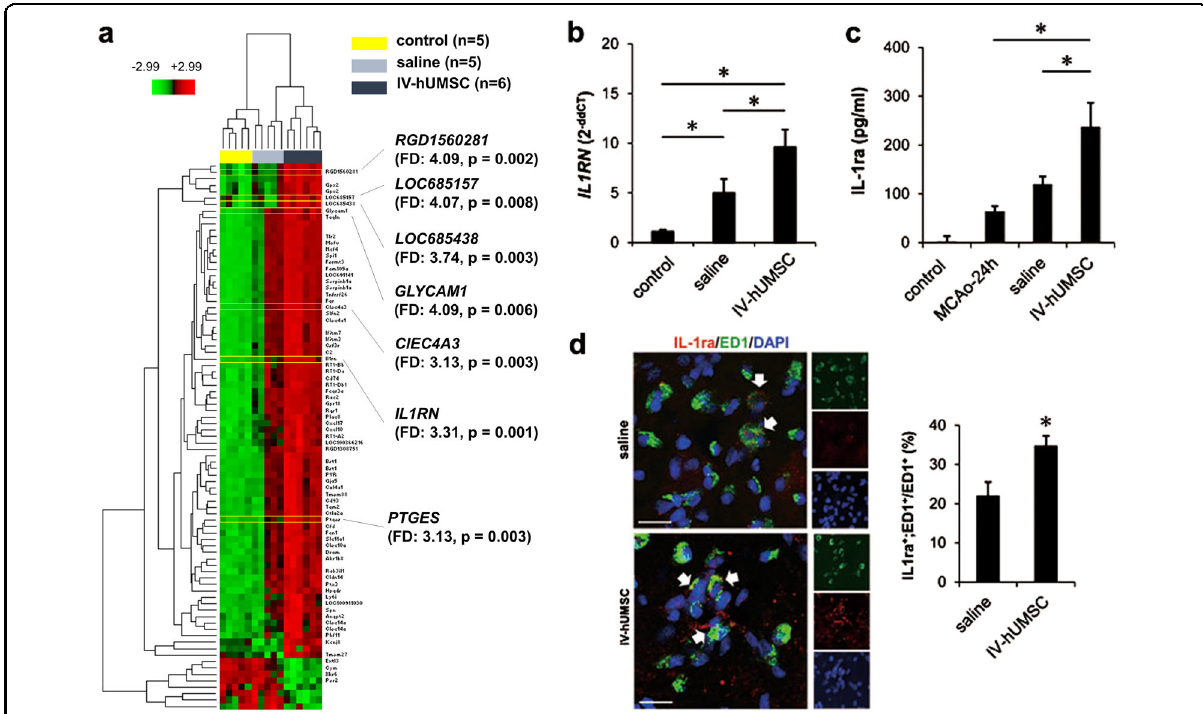
Fig. 4 IL-1ra expression in MCAo rats treated with IV-hUMSCs. a mRNA microarray analysis on the ischemic brain of MCAo rats treated with IV- hUMSCs ( n = 6) or saline ( n = 5) at 24 h post MCAo. Normal rat brain was used as a control ( n = 5). A heat map of a total of 85 differentially expressed genes (fold difference ≥ 2 and p < 0.01 after Benjamini – Hochberg ’ s correction) is presented in the left panel. The transcripts listed in the right panel represent the most highly expressed transcripts between the IV-hUMSC group and saline group (fold difference ≥ 3 and p < 0.01 after Benjamini – Hochberg ’ s correction). FD represents the fold difference. p represents the p value. b Real-time PCR of IL1RN in brain tissue in the IV- hUMSC group and saline group. The fold difference was represented as a 2 − ddCT value. * p < 0.05. c Enzyme-linked immunosorbent assay (ELISA) of IL- 1ra in the ischemic hemisphere of rats with no MCAo (control), rats with 24 h post MCAo (MCAo-24 h), rats with 72 h post MCAo treated with saline (saline group), and rats with 72 h post MCAo treated with 1 × 10 6 IV-hUMSCs at 24 h post MCAo (IV-hUMSC group) ( n = 5 in each group). d IL-1ra and ED-1 double immunostaining (arrows) in the ischemic brain in the IV-hUMSC group and saline group ( n = 5 in each group). All data are presented as the mean ± SEM. * p < 0.05. Scale bar = 20 μ